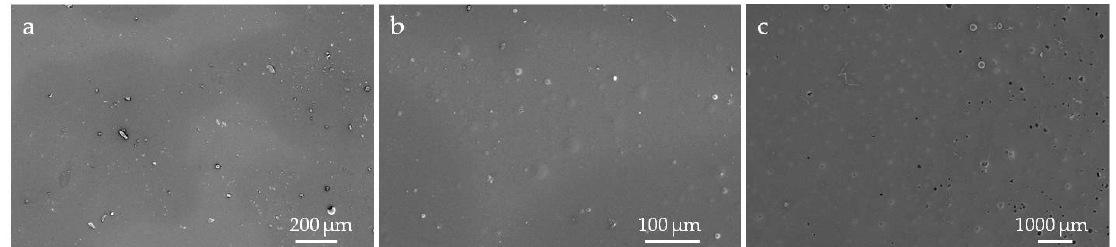
Figure 3. SEM images of test surfaces with integrated particles. From left to right: ( a ) surface of the silicone mixture without particles, ( b ) surface of the silicone mixture integrated with Poraver particles and ( c ) surface of the silicone mixture integrated with Q-Cel particles.